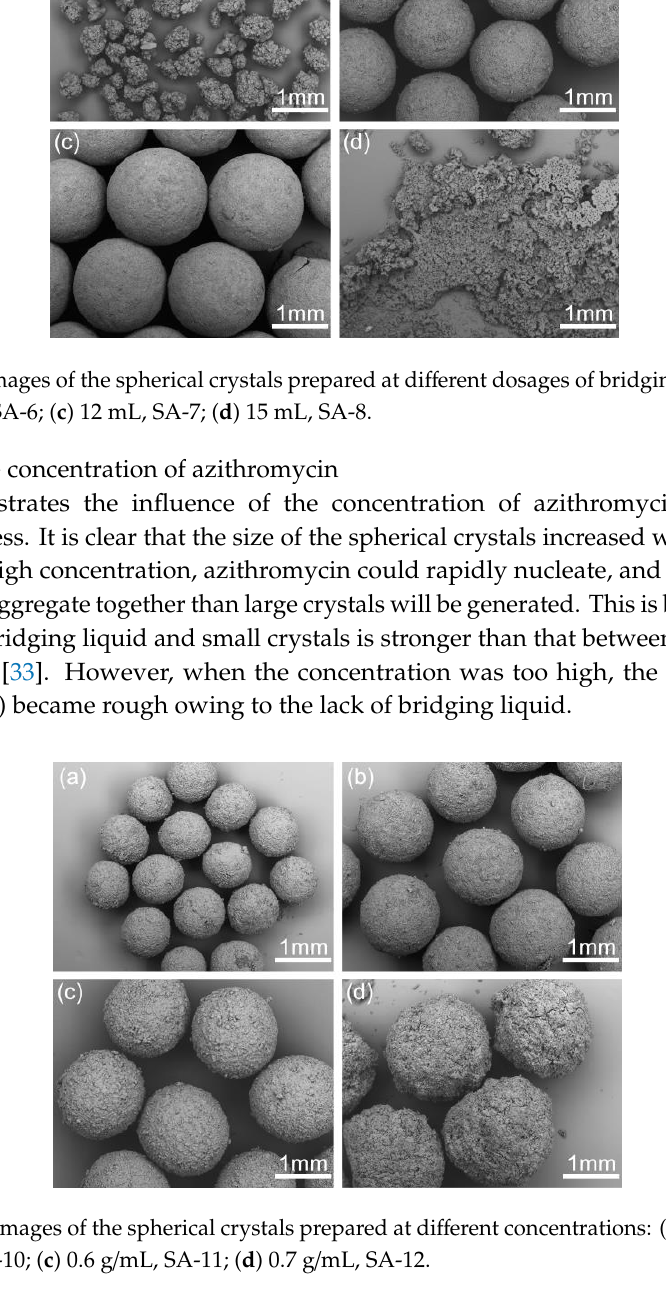
Processes 2019 , 7 , x FOR PEER REVIEW 10 of 17 Figure 8. SEM images of the spherical crystals prepared at different stirring speeds: ( a ) 300 rpm, SA-1; ( b ) 500 rpm, SA-2; ( c ) 700 rpm, SA-3; ( d ) 1000 rpm, SA-4. (2) Effect of the dosage of bridging liquid The effect of dosage of bridging liquid on the quality of products are shown in Figure 9. The dosage of bridging liquid apparently affects the formation of spherical crystals. As shown in Figure 9a, due to the lack of the bridging liquid, the spherical particles became irregular and rough. However, the agglomerates became large and smooth with the increase of the dosage of bridging